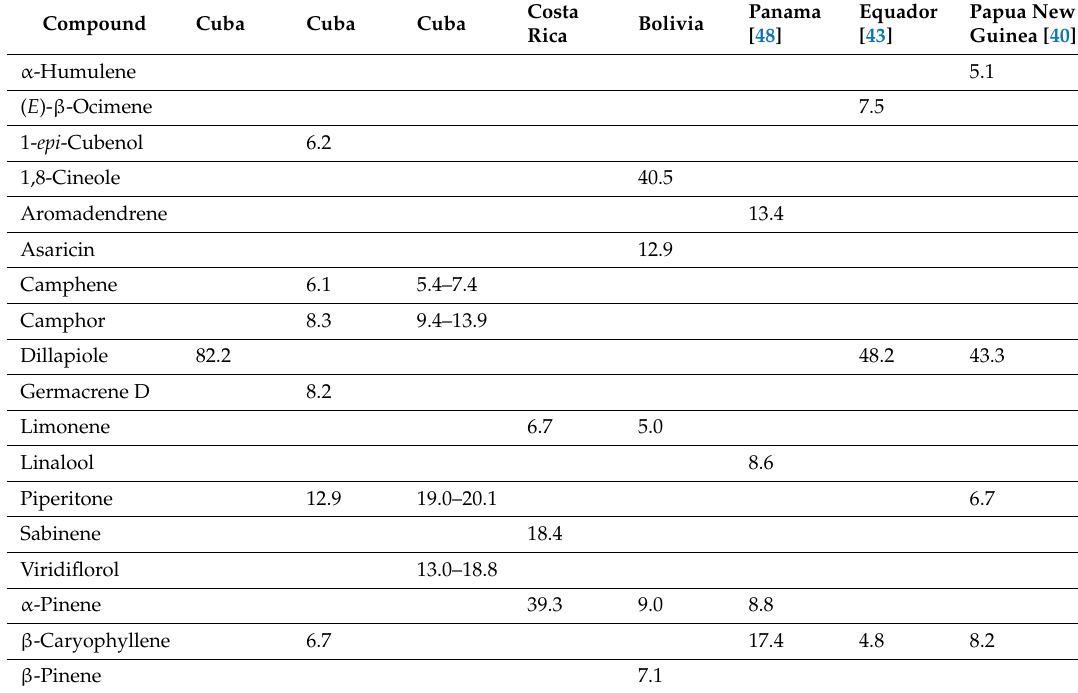
Table 2. Chemical compositions (%) of Piper aduncum leaf essential oils from countries other than Brazil.